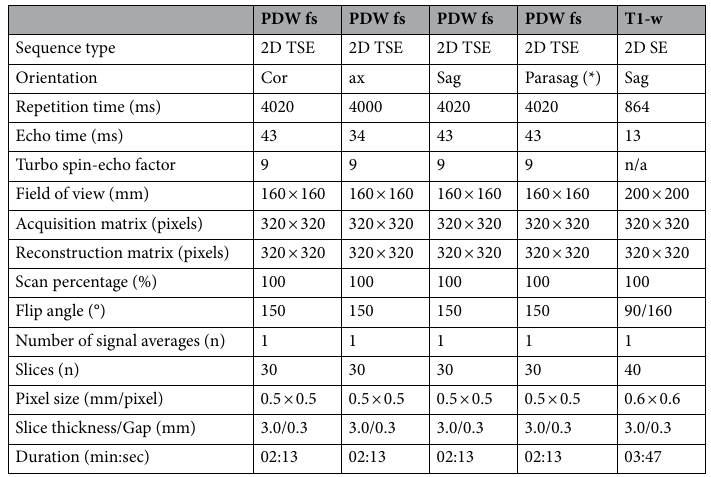
Table 3. Acquisition parameters of MR sequences. PDW—Proton Density-weighted, fs—fat-saturated, TSE— turbospin-echo, SE—spin-echo, w—weighted, cor—coronal, ax—axial, (para)sag—(para)sagittal, n/a—not applicable. (*) aligned to the course of the